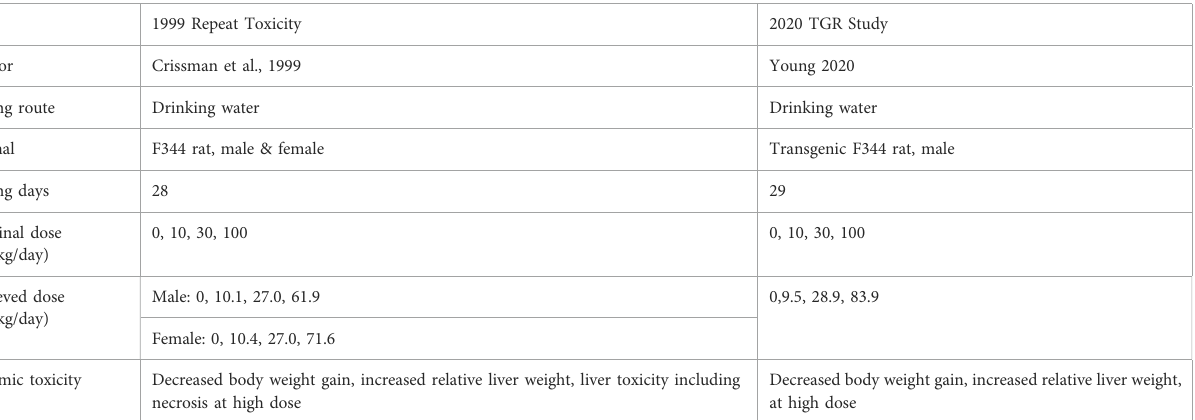
TABLE 4 3-CAA partition coef fi